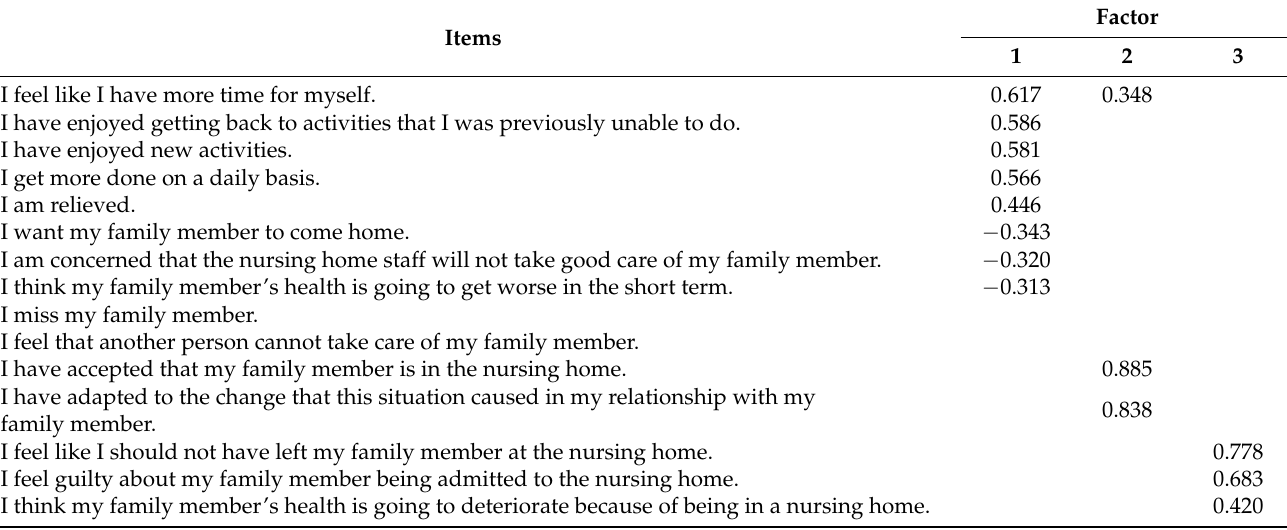
Table 3. Configuration